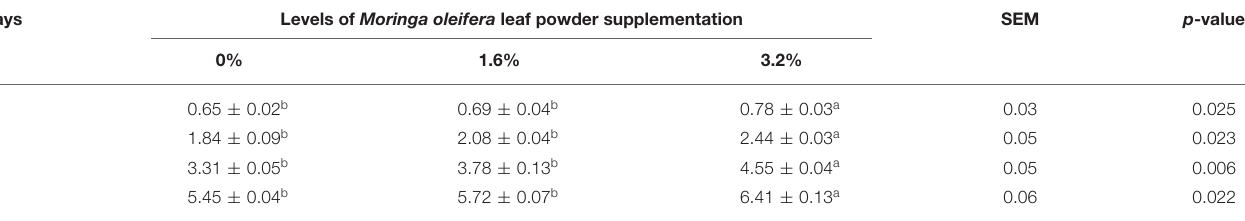
TABLE 7 | Plasma progesterone (ng/mL) profile of pregnant beetal goats. Days Levels of Moringa oleifera leaf powder